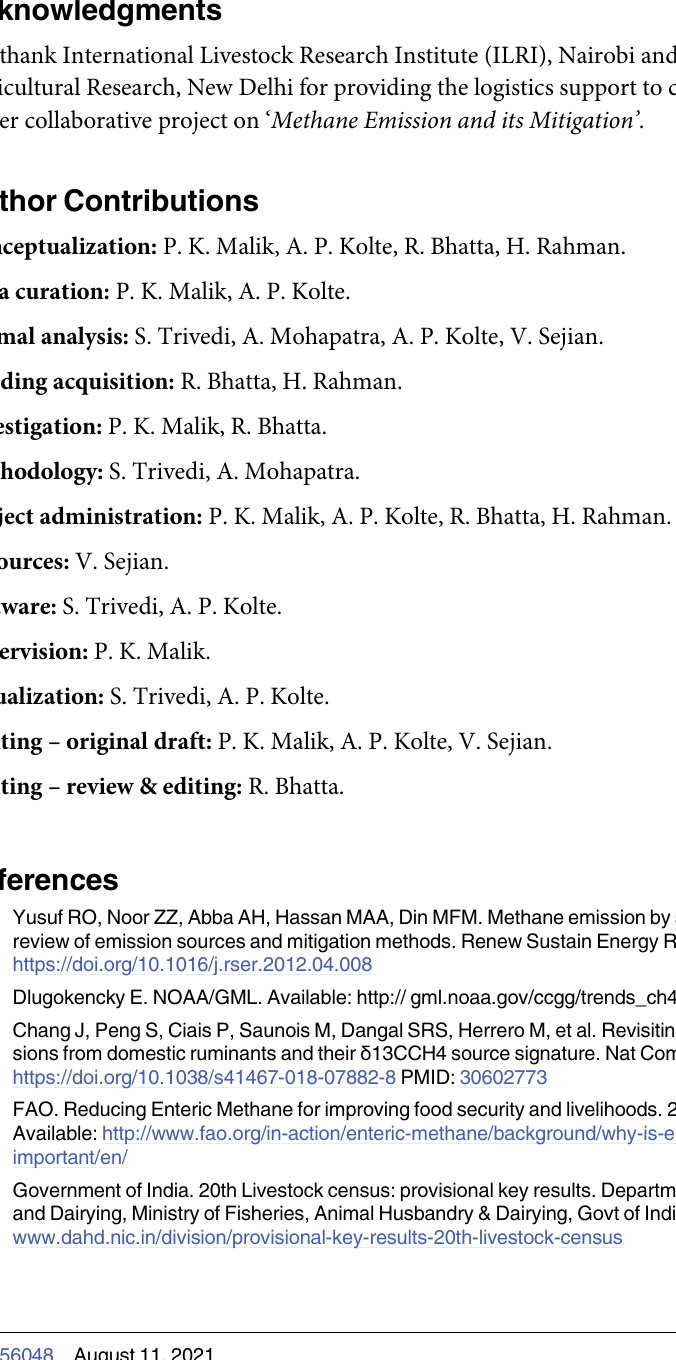
S1 Table. Chemical composition of feed. S1 Fig. Rarefaction plot showing the numbers of archaeal